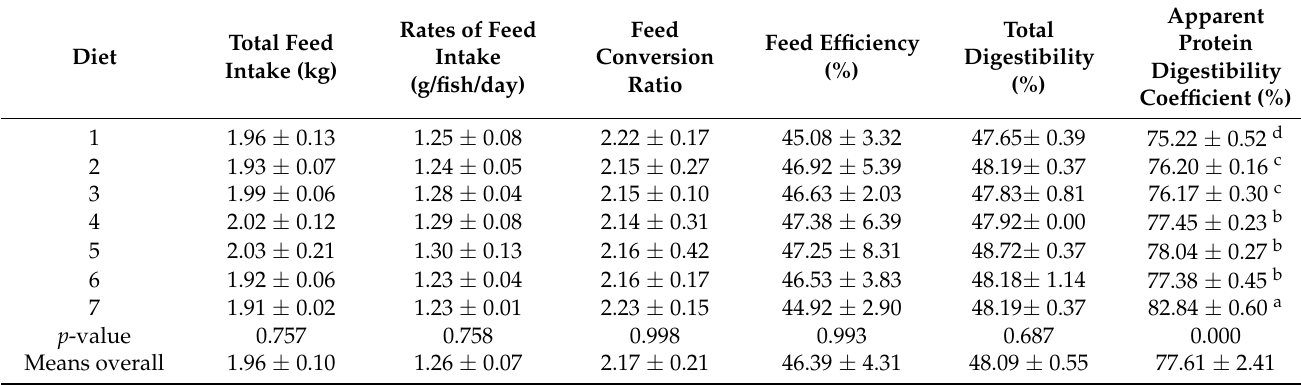
Table 4. Feed utilization (mean ± SD) after 12 weeks of feeding with control (0% BSFLM and 100% FM), and FM replaced at 10%, 20%, 40%, 60%, 80%, and 100% of the BSFLM.